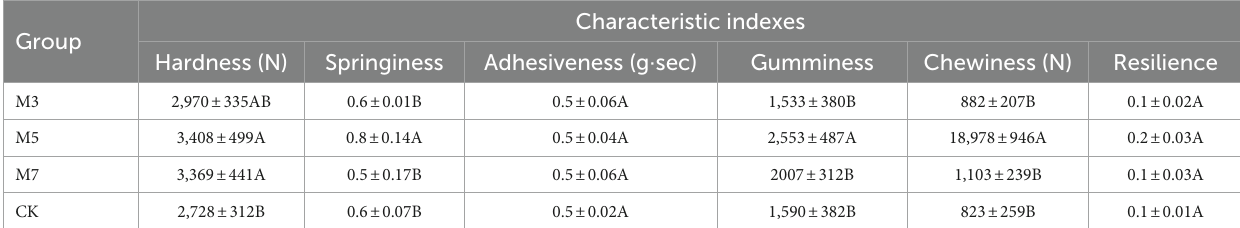
TABLE 2 TPA of fermented sausage at 8